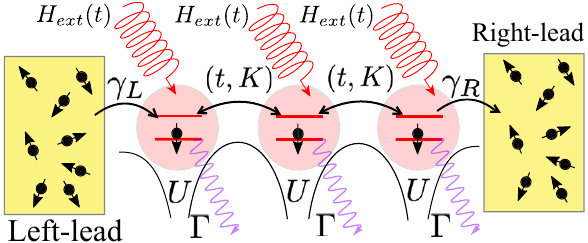
Fig. 1 Schematic arrangement of the quantum-dot array set-up. t , U , and K are the hopping, onsite and nearest-neighbor interactions, respectively. V ( t ) represents the external time-periodic drive. γ L and γ R are the system left-lead and system right-lead couplings, respectively (note the direction of the arrow indicating the one-way electron transfer, i.e., an in fi nite bias condition) which is taken to be the same for both spin-up and spin-down electrons. Onsite dephasing is given by Γ